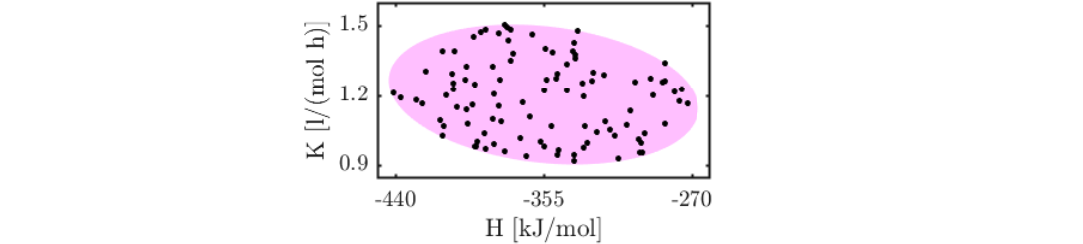
Figure 8. Parameter combinations considered to be the true realization of the uncertain parameters chosen within the initial confidence region of the uncertain parameters to evaluate the performance NMPC controllers for different values of the tuning